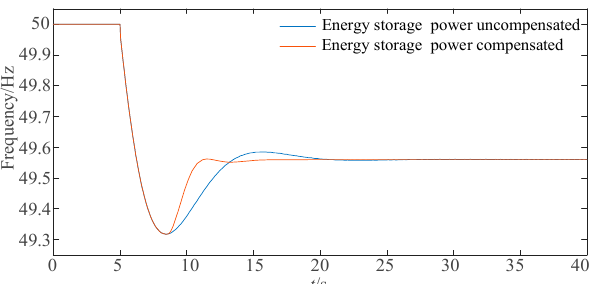
load increases by 0.5 MW; ( b ) Strategy comparison when the load increases by 1.5 MW; ( c ) Strategy